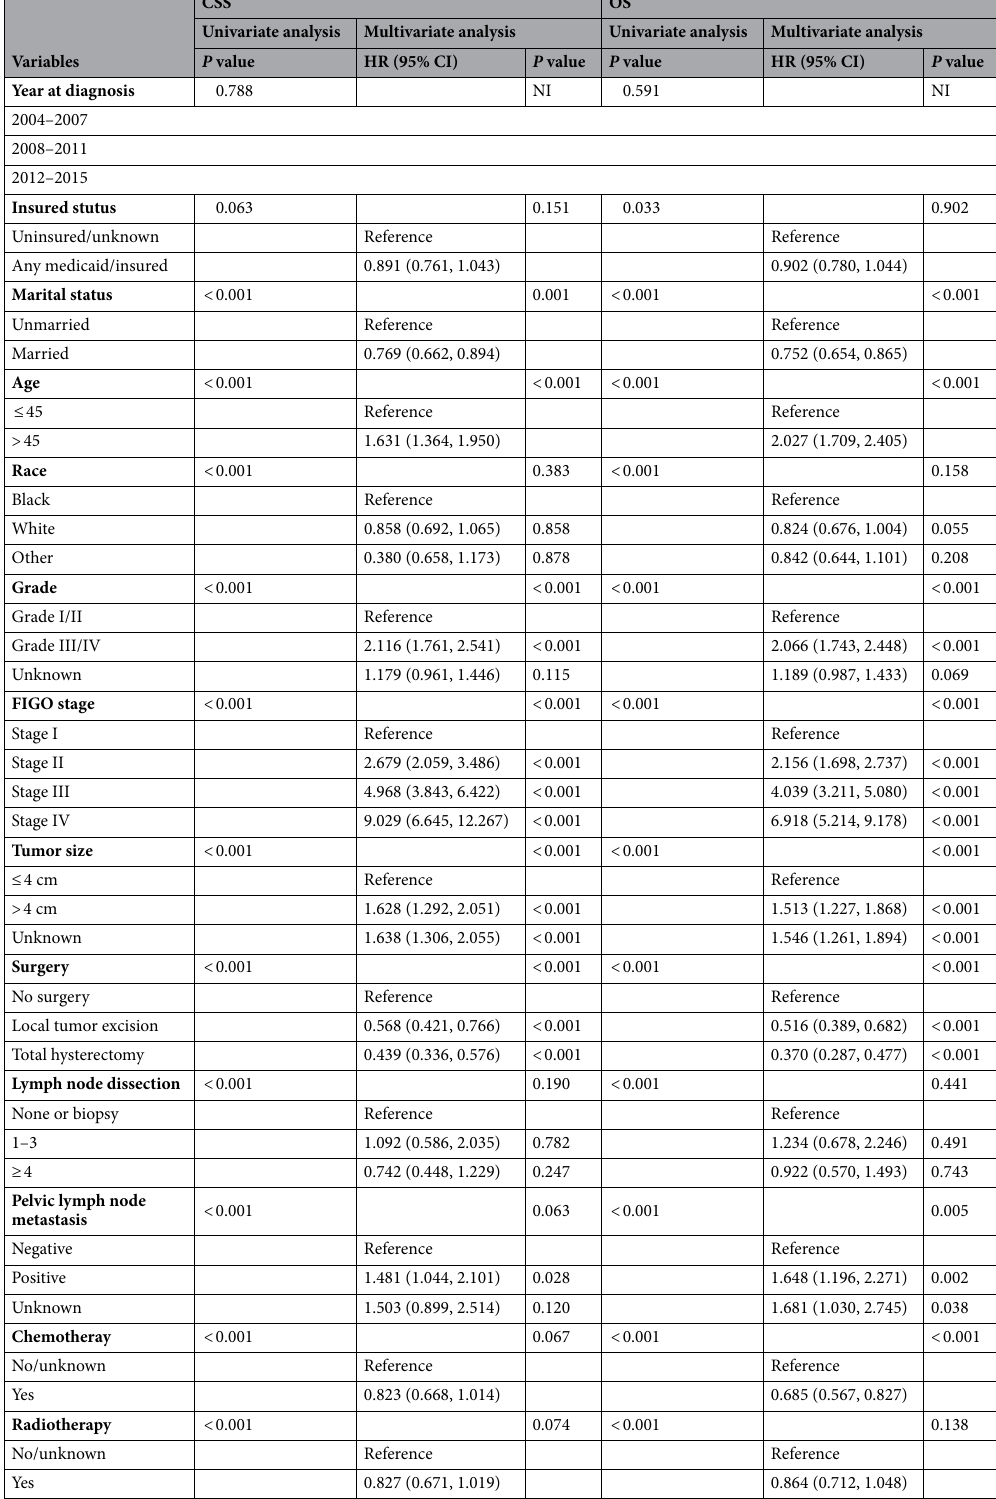
Table 3. Univariate and multivariate analyses of cancer special survival (CSS) and overall survival (OS) for patients. CSS cancer ‐ specific survival, OS overall survival, NI not included in the multivariate survival